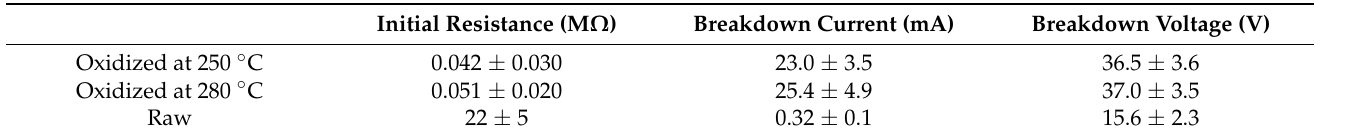
Table 2. Initial resistance and electrical breakdown characteristics for the raw and oxidized powders. The thickness of the samples was 0.30 mm.